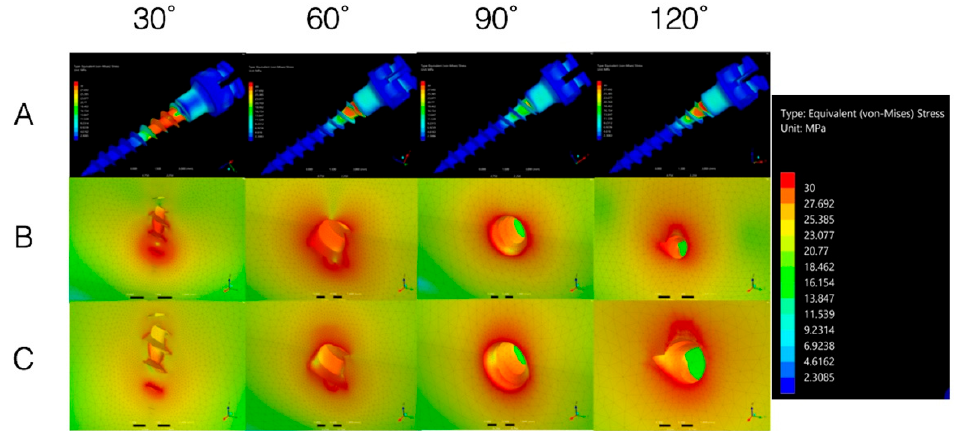
Figure 4. ( A ) Mini-implant von Mises stress; ( B ) Cortical bone von Mises stress with CBT of 1 mm; ( C ) Cortical bone stress with CBT of 2 mm.